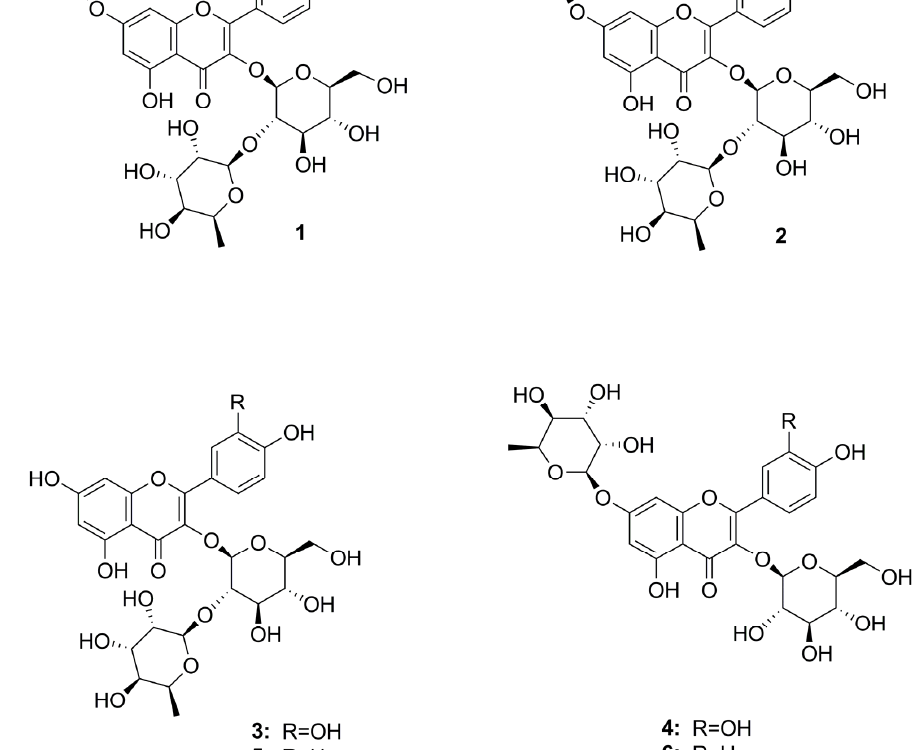
Figure 5. Chemical structures of isolated flavonoids quercetin 3-O-(2 ″ -O- α -L-rhamnopyranosyl)- β - D-glucopyranoside 7-O- β -D-rhamnopyranoside ( 1 ), kaempferol 3-O-(2 ″ -O- α -L-rhamnopyranosyl)- β -D-glucopyranoside 7-O- β -D-rhamnopyranoside ( 2 ), quercetin 3-O-(2 ″ -O- α -L-rhamnopyranosyl)- β -D glucopyranoside ( 3 ), quercetin 3-O- β -D-glucopyranoside 7-O- β -D-rhamnopyranoside ( 4 ), kaempferol 3-O-(2 ″ -O- α -L-rhamnopyranosyl)- β -D glucopyranoside ( 5 ), and kaempferol 3-O- β -D glucopyra- noside 7-O- β -D-rhamnopyranoside ( 6